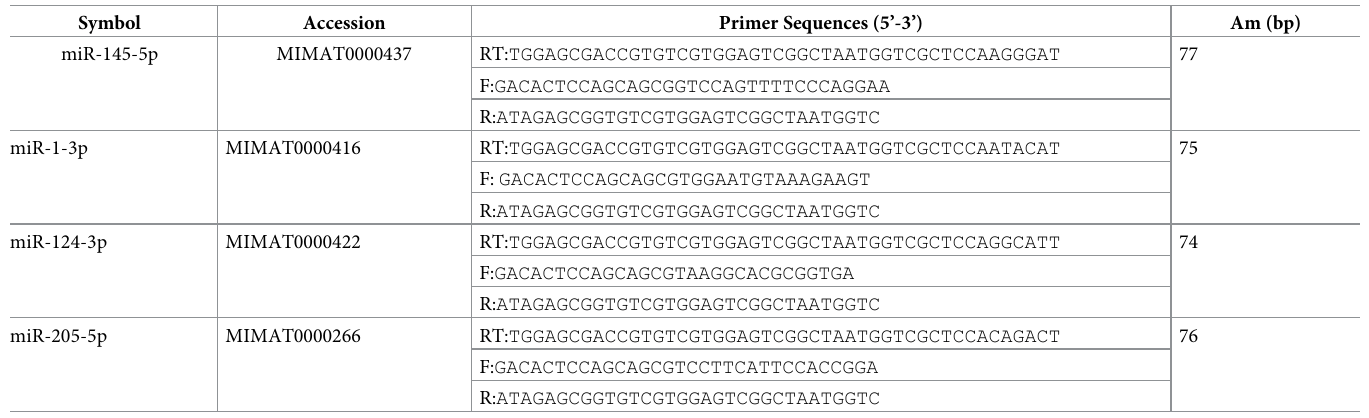
Fig 2. Comparisons of mir-145-5p and ACTB levels in the five groups. (A) Expressionof miR-145-5p were detected by RT-qPCR; (B-C) The mRNA and protein levels of ACTB was detected by RT-qPCR and western blot, respectively. � P < 0.05 compared with control group; �� P < 0.05 compared with miR-145 inhibitors group. https://doi.org/10.1371/journal.pone.0210087.g002 miR-124-3p, and miR-205-5p) showed no significant differences, but miR-145-5p level was significantly higher in Hcy-treated group (Fig 3). MiR-145-5p suppressed ACTB expression induced by Hcy. According to the levels of miR-145-5p and ACTB detected in the two groups, the Hcy-treated group had higher miR- 145-5p expression than the control group, while the miR-145 inhibitor and Hcy group dis- played lower miR-145-5p expression than the miR-145 inhibitor group (Fig 2A). When Table 4. Primers for target